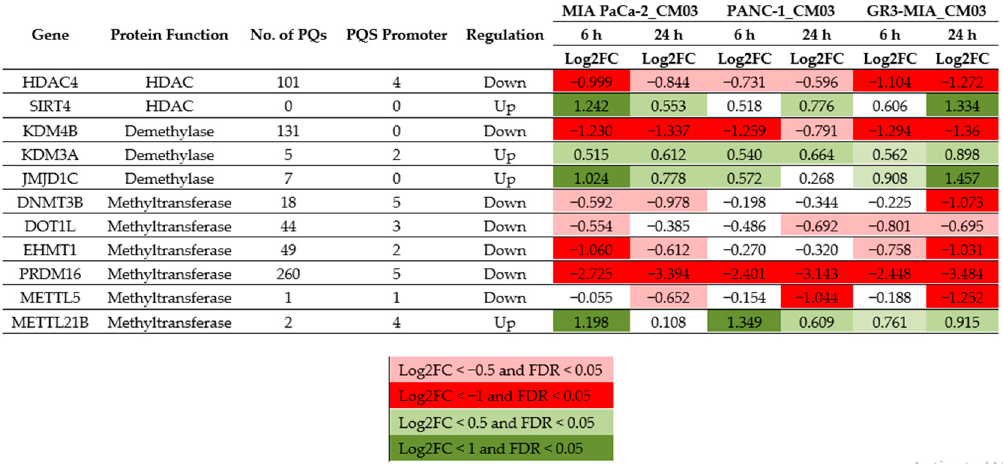
Figure 5. Table of selected epigenetic-related genes and the effects of CM03 on gene expression in pancreatic cancer cell lines. Log2 FC fold changes in gene expression are shown, from RNA-seq analyses. PQs are estimated numbers of putative quadruplex sites. Data taken from [8,10]. Expression changes are grouped in four colour-coded sets, as shown, according to size of change .